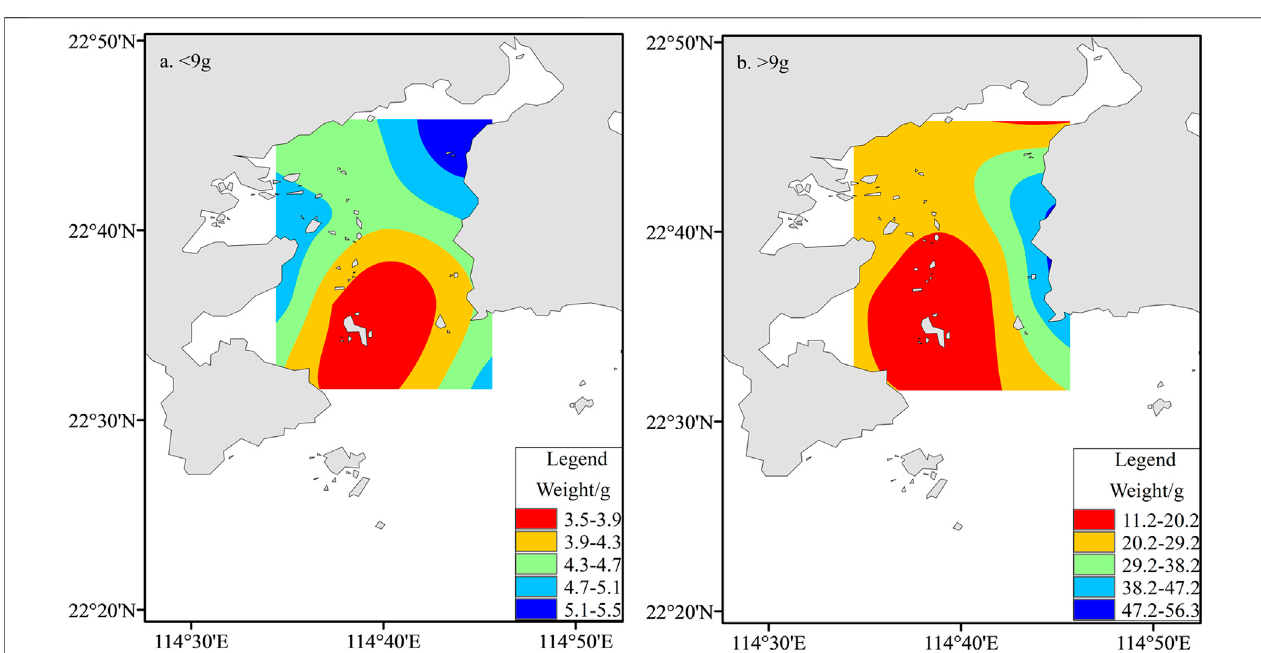
FIGURE 2 | Spatial distribution of fi sh physically in two designated size classes in Daya Bay; (A) small fi sh < 9 g wet weight; (B) large fi sh > 9 g wet